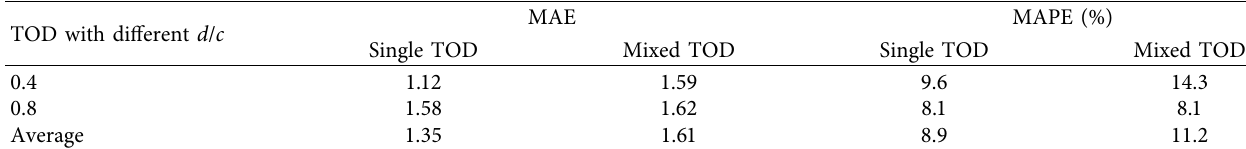
Table 3: Estimation results with LPR data in diferent TOD.